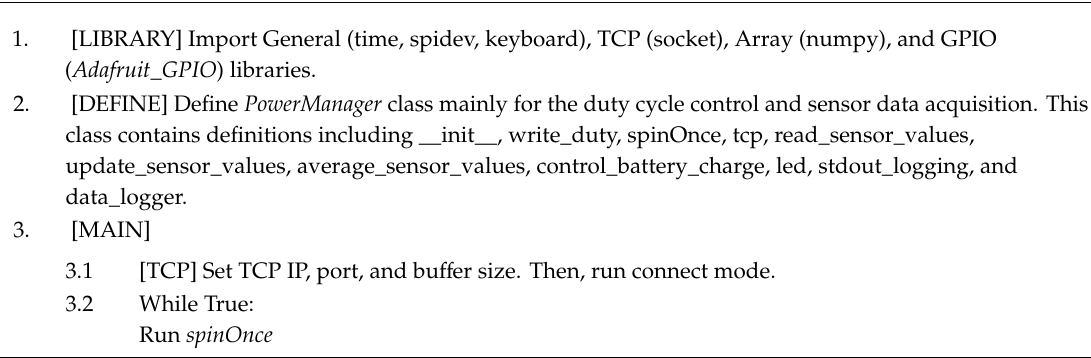
Table 2. Specifications of the photovoltaic (PV) cell.